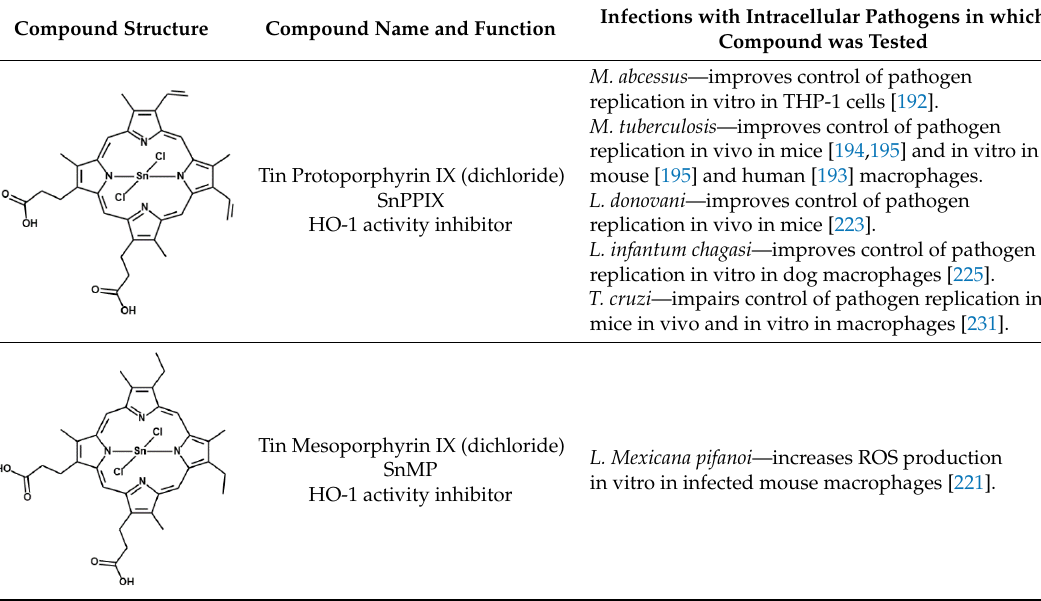
Table 1. Structures and names of most common HO-1 inhibitors and inducers tested in infections with intracellular pathogens.